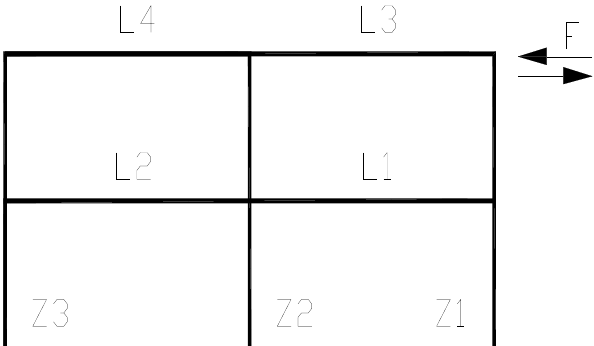
Figure 6. Schematic diagram of the frame.